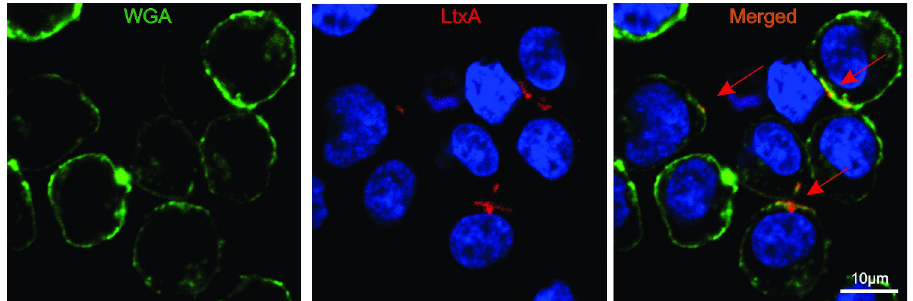
Fig 2. LtxA associates with the plasma membrane of Jn.9 cells. Confocal images of Jn.9 cells treated with 20 nM LtxA-DY650 (red) for 15 min show evidence of membrane localization by the toxin. The membranes were stained with WGA-AF488 (green) and the cell nuclei with Hoescht (blue). Arrows demonstrate areas of colocalization of LtxA with the